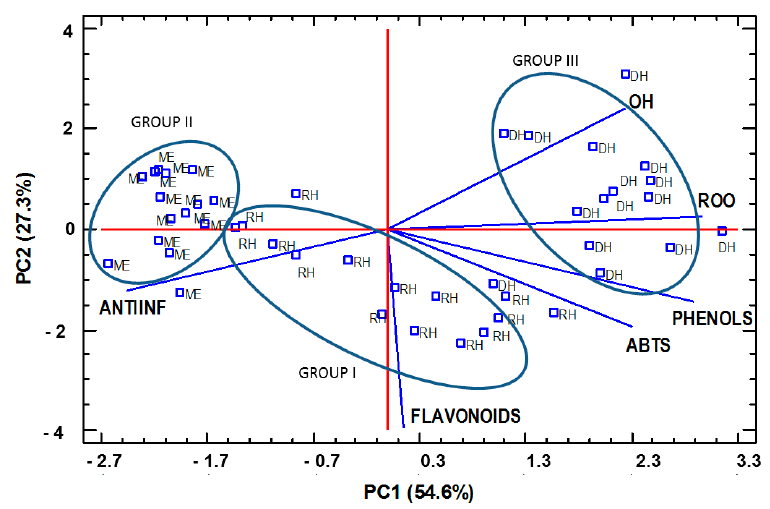
Figure 4. Principal components analysis derivate from phenols compositions, antioxidant and anti-inflammatory activity of RH, ME and DH.